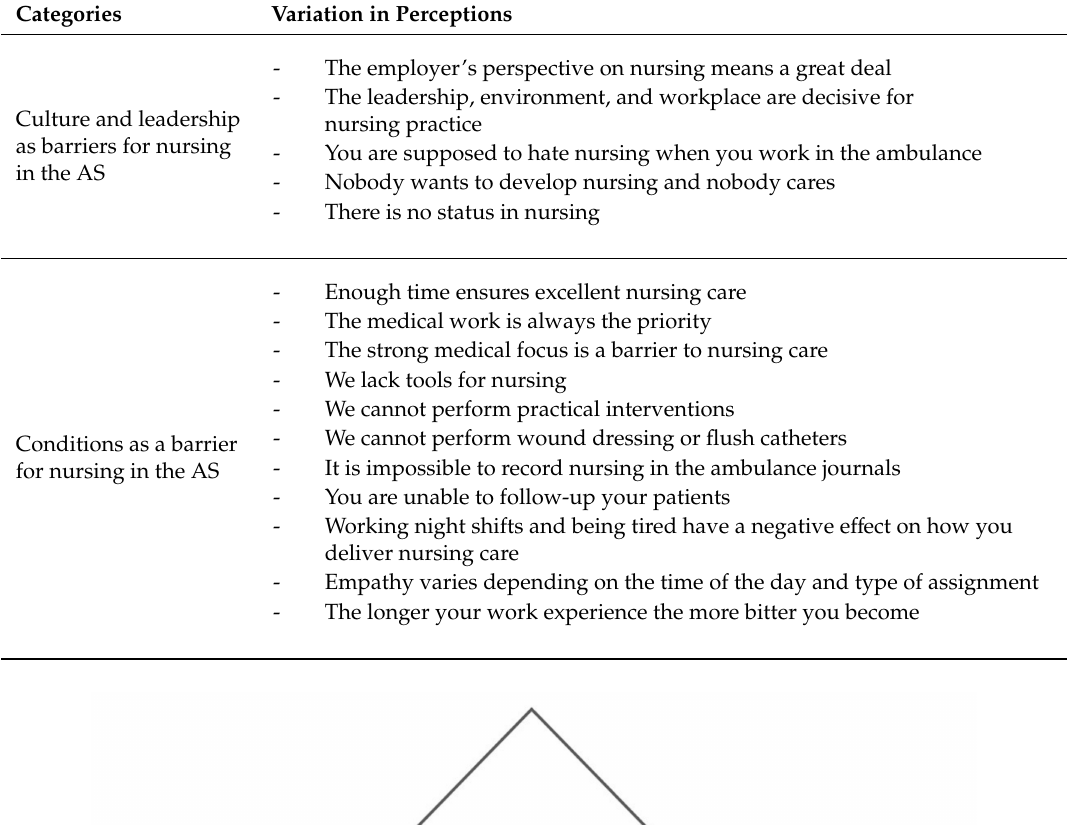
Table 3. The SANs’ perceptions of the Ambulance Service context and organization a ff ecting their perceived role and responsibilities.